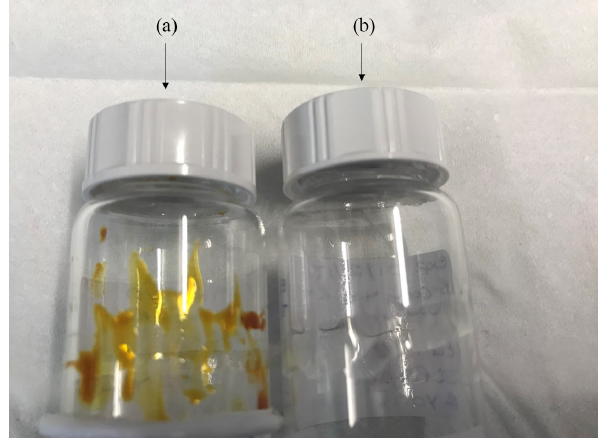
Figure 3. Visual differences observed in the light-absorbing prop- erties of toluene (a) and β -caryophyllene SOA (b) formed under replicate experimental conditions (55% relative humidity with a VOC / NO x ratio of 13, exps. 36 and 31, respectively (see Table